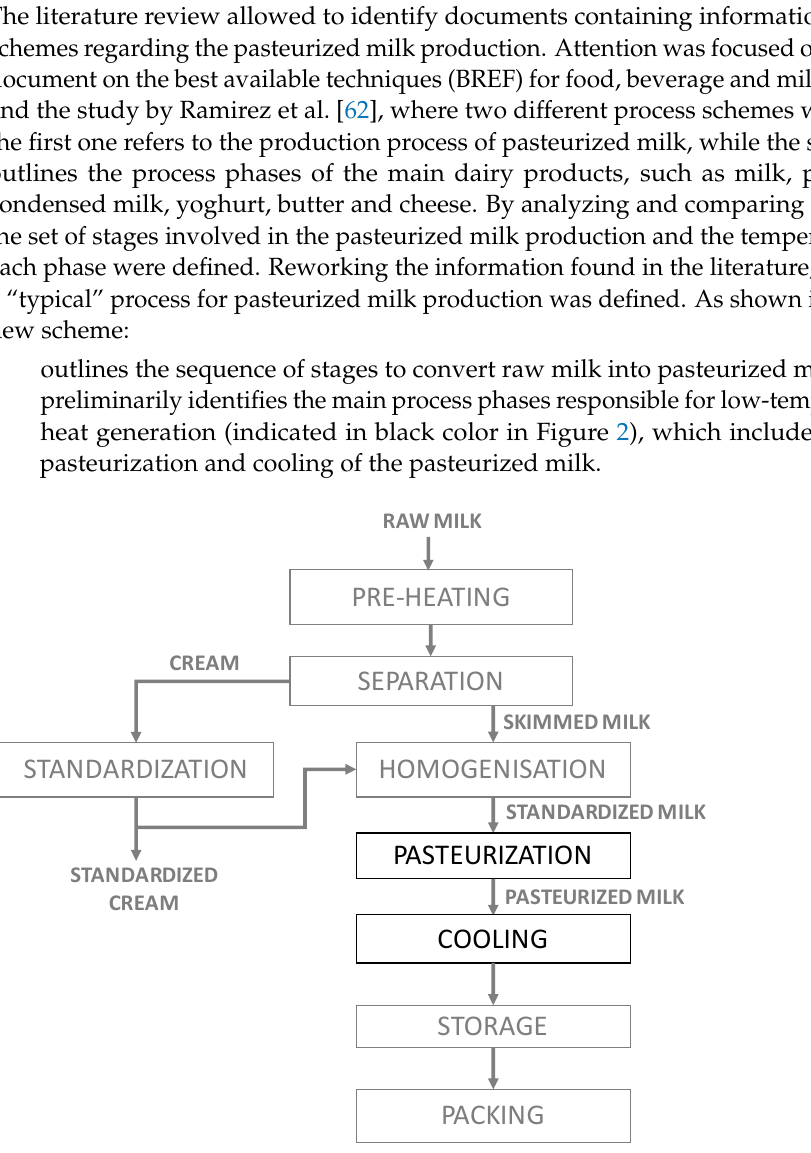
Figure 3. Scheme of low-temperature waste heat sources in pasteurized milk processing (from au- thors’ elaboration). 3.1. Analysis of the Energy Audits of the Italian Dairy Sector With the aim to validate, improve and contextualize the scheme of pasteurized milk production process and the corresponding scheme of low-temperature waste heat sources to the Italian dairy industry, energy audits carried out by large and energy-intensive en- terprises in the year 2019, in compliance with the Legislative Decree N. 102 of 4 July 2014 [55], were examined. The paragraph outlines the main findings of this analysis, with a focus on waste heat sources identified within the manufacturing processes of dairy prod- ucts and the waste heat recovery interventions envisaged by enterprises to improve their energy efficiency. It is important to emphasize that such information is rarely clearly